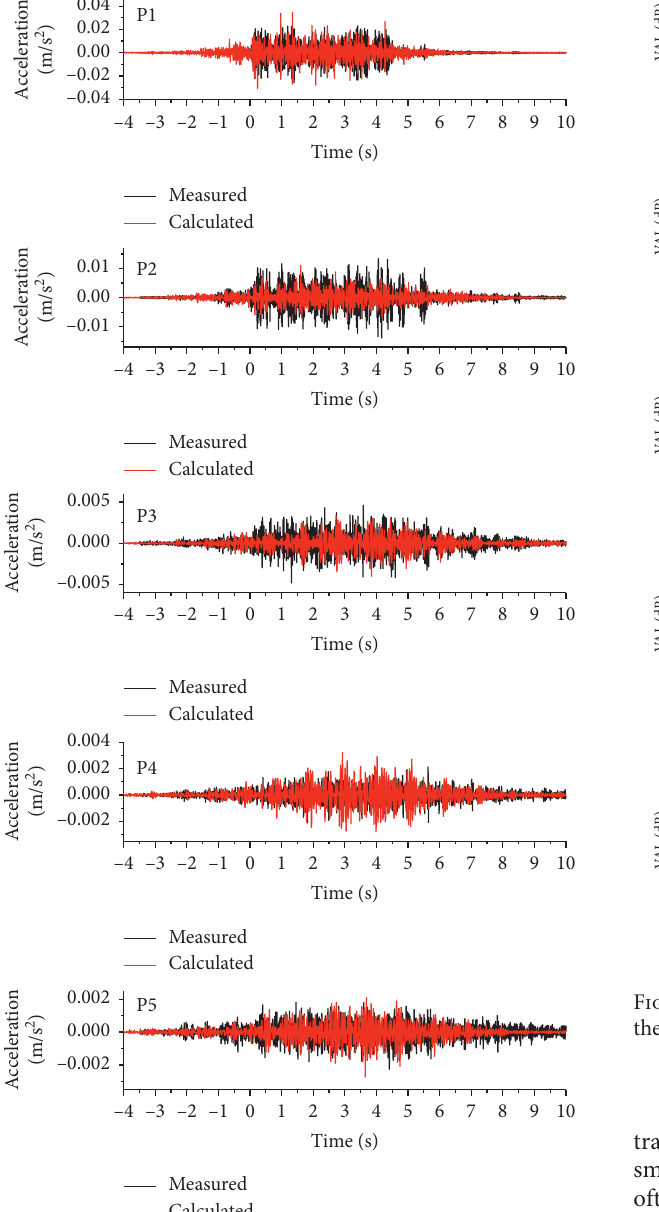
Figure 4: Comparison of calculated time histories to the measured data, recorded at 7:40 am on March 6, 2007.